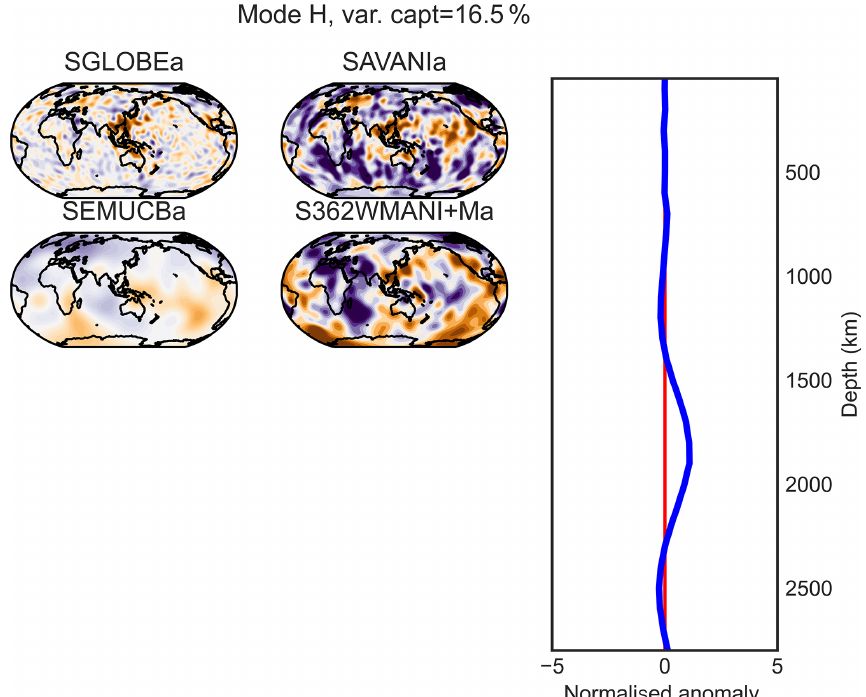
Figure E8. PC H (maximum at 1900km of depth) of the combined analysis of the anisotropic parts of the models.